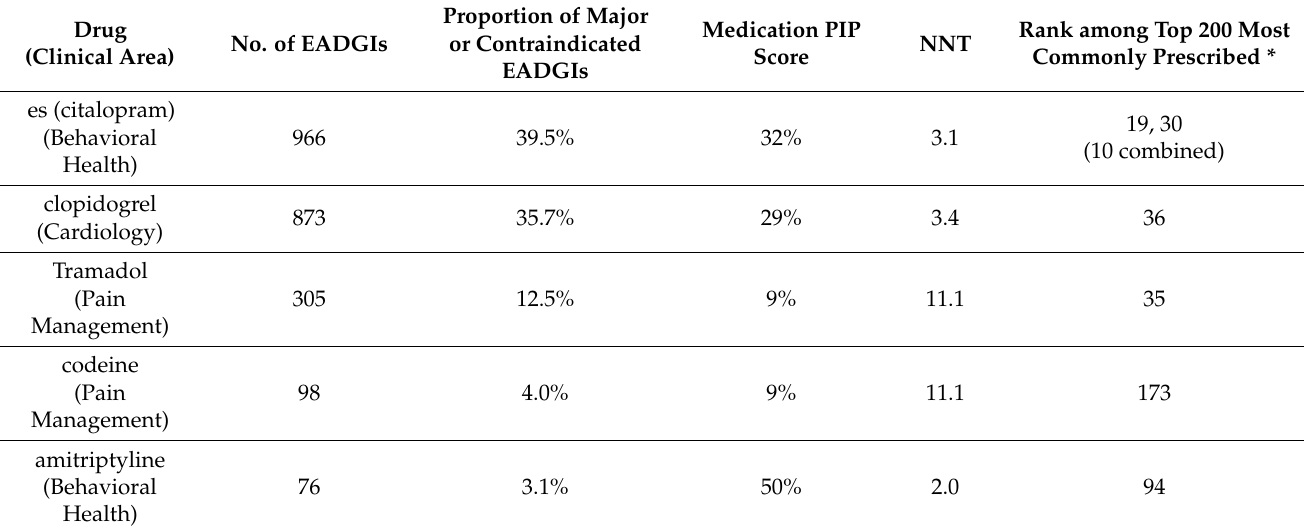
Table 6. Top five medications with major or contraindicated